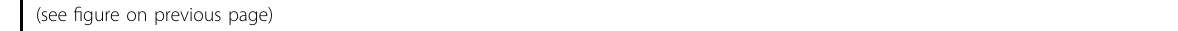
Fig. 1 Overall structures of VAR2CSA ectodomain. a Schematic sequence architecture of VAR2CSA of P. falciparum 3D7 strain. Domains reconstructed according to the cryo-EM density map were colored respectively. NTS, orange; DBL1X, aquamarine; DBL2X, pale green; ID2a, violet; ID2b, salmon; DBL3X, wheat; DBL4 ɛ , light blue; ID3, pale yellow; DBL5 ɛ , green; DBL6 ɛ , red; ID1, gray. Color codes were used throughout this study unless otherwise noted. b The ribbon diagram of apo VAR2CSA ectodomain core region. c The ribbon diagram of VAR2CSA-CSA core region. The core center was highlighted using red ovals in b and c . d – f Structural comparison between VAR2CSA-CSA with apo VAR2CSA ectodomain by aligning DBL4 ɛ domains. The helix associated with CSA in DBL2X domain exhibited a 1.8 Å bend outward at the binding site while the distal end remained fi xed ( d ). The sur fi cial helixes in DBL2X moved about 2 Å toward the CSA binding pocket ( e ). The DBL1X domain went through a signi fi cant conformational change at a distance of more than 3.2 Å to close the CSA binding pocket ( f ). g Interactions between CSA and VAR2CSA were shown in the binding pocket. Interacting residues from NTS, DBL2X, and DBL4 ɛ were highlighted individually. h Gel fi ltration chromatography of VAR2CSA- 50-962 and VAR2CSA-50-962-9-site-mutation (N557D, K561E, K562E, N576D, K828E, R829E, Q832E, K835E, R846E) in the presence or absence of CSA on a Superose 6 increase 10/300 GL column. i The binding kinetics of VAR2CSA ectodomain, VAR2CSA-50-962, and VAR2CSA-50-962-9-site-mutation were further assessed using Octet RED 96, and equilibrium constant ( K D ) values were calculated accordingly. j The binding activities of VAR2CSA-50- 962, VAR2CSA ectodomain, and VAR2CSA-50-962-9-site-mutation to JEG-3 cells or HepG2 cells were tested by immuno fl uorescence assay using confocal fl uorescence microscopy, respectively. Green (stained with anti-His-FITC antibody) indicated VAR2CSA proteins; blue (DAPI) represented cell nuclei. k Model of VAR2CSA recognizing both placental cells and tumor cells. The cartoon exhibited the mechanism of VAR2CSA capturing the CSA ligand and showed the conformational change upon CSA binding in a red frame. The cartoon also illustrated the mechanism of VAR2CSA characteristically recognizing either placental cells or tumor cells by identifying the speci fi c CSA displayed on the cell surface. VAR2CSA was drawn as cannibal plants in two states corresponding to CSA binding or not, respectively. CSA modi fi cations were drawn as zombies and other glycol- modi fi cations as sun fl owers. Cells were depicted as balloons in different colors. Tumor cells, salmon; Placental cells, yellow; Normal cells, light